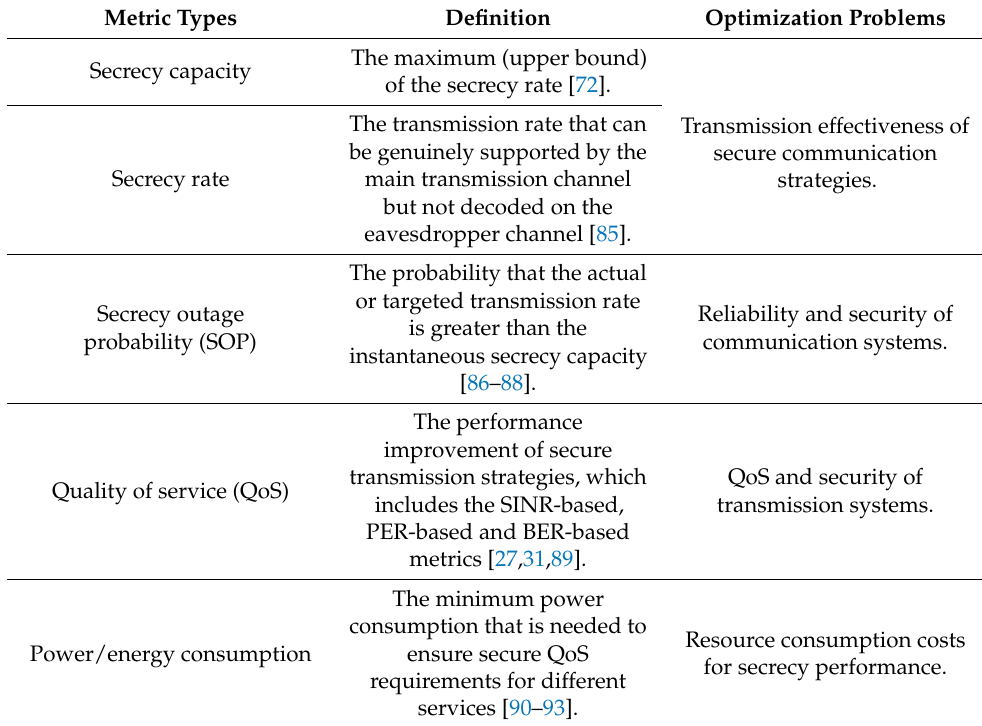
Table 3. Summary of performance metrics for PHY